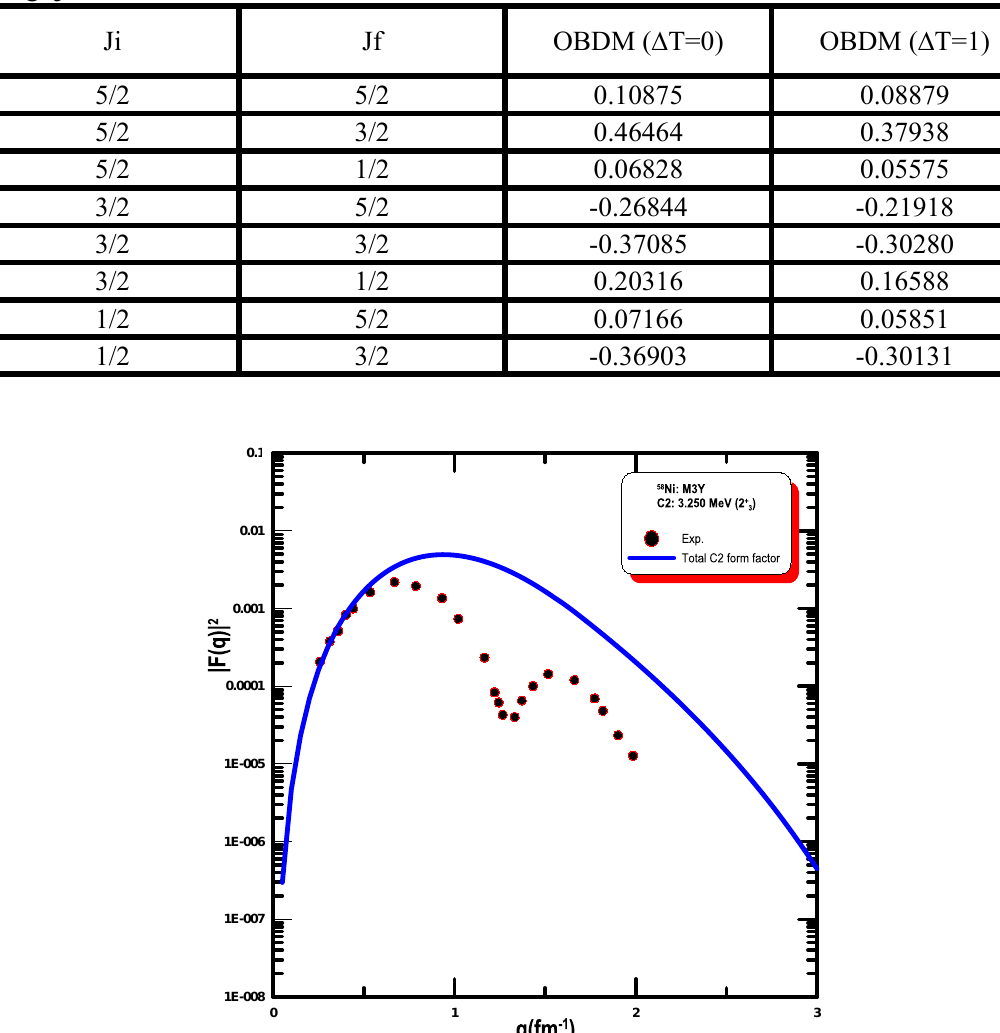
Fig.5: Inelastic longitudinal C2 form factors for the  with M3Y as a residual interaction (solid curve), the experimental data (filled circles) are taken from Ref.